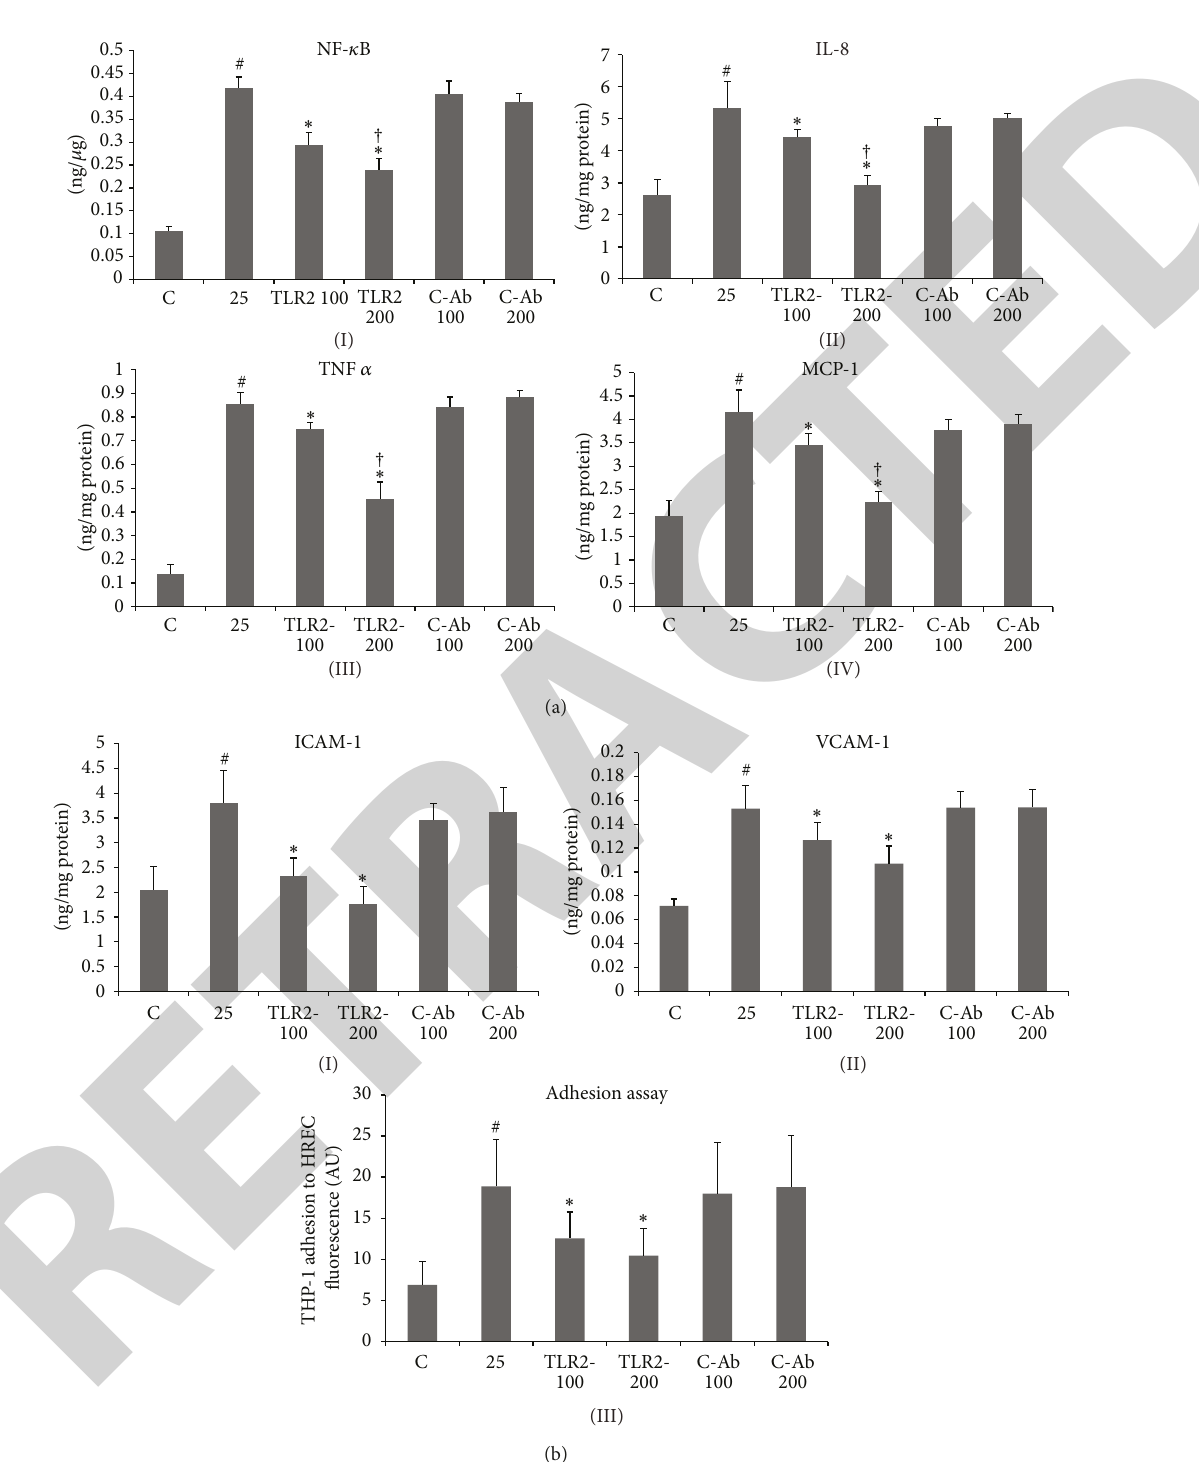
Figure 7: (a) TLR-2 inhibition by TLR-2 neutralizing antibody attenuates downstream inflammatory biomediators: HMVRECs were serum starved for 2 hours and treated with 100 and 200 nM TLR-2 neutralizing antibody for 2 hours. Thereafter 5.5 and 25 mM glucose treatments were performed as described in Figure 3. (I) NF- 𝜅 B, (II) TNF- 𝛼 , (III) IL-8, and (IV) MCP-1 levels are significantly decreased upon TLR-2 inhibition compared to HG treatment. # 𝑃 < 0.001 versus control, ∗ 𝑃 < 0.001 versus 25 mM, and † 𝑃 < 0.01 versus 100nM. (b) Cell adhesion molecules ICAM-1 and VCAM-1 attenuation upon TLR-2 neutralizing antibody treatment. HMVRECs were serum starved for 2 hours and treated with 100 and 200 nM TLR-2 neutralizing antibody for 2 hours. Thereafter 5.5 and 25 mM glucose treatments were performed as described in Figure 4. Adhesion molecules (I) ICAM-1 and (II) VCAM-1 levels are significantly decreased upon TLR-2 inhibition. # 𝑃 < 0.001 versus control and ∗ 𝑃 < 0.001 versus 25 mM. (III) Adhesion assay showing decreased cell adhesion with TLR-2 inhibition. # 𝑃 < 0.001 versus control and ∗ 𝑃 < 0.01 versus 25